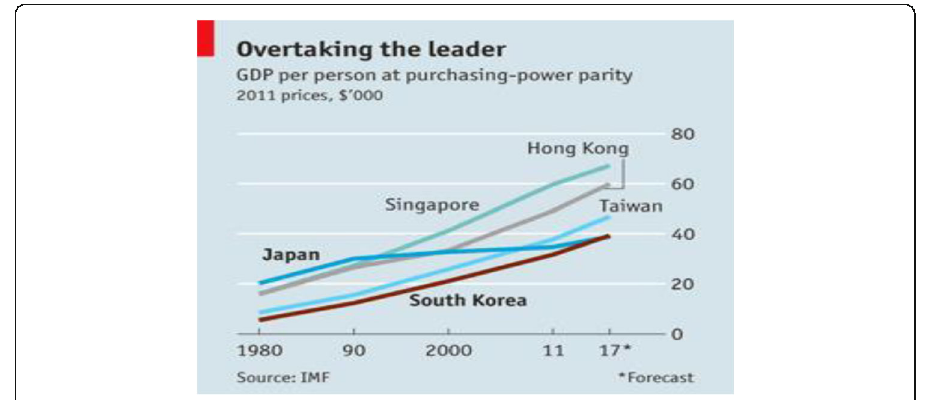
Fig. 1 Overall comparative GDP in selected Asian economies 1980 – 2017. Source : (IMF,